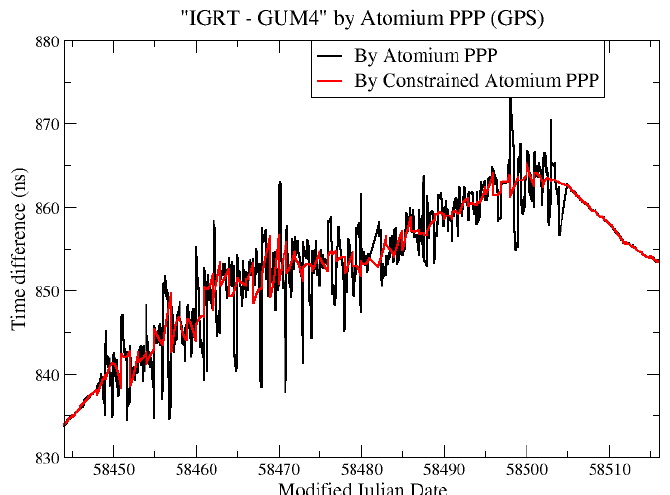
Figure 12. “IGRT—GUM4” from constrained and non-constrained PPP.